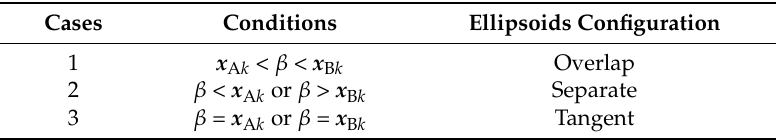
Table 2. Conditions for the intersection relationship of an ellipsoid with a plane.